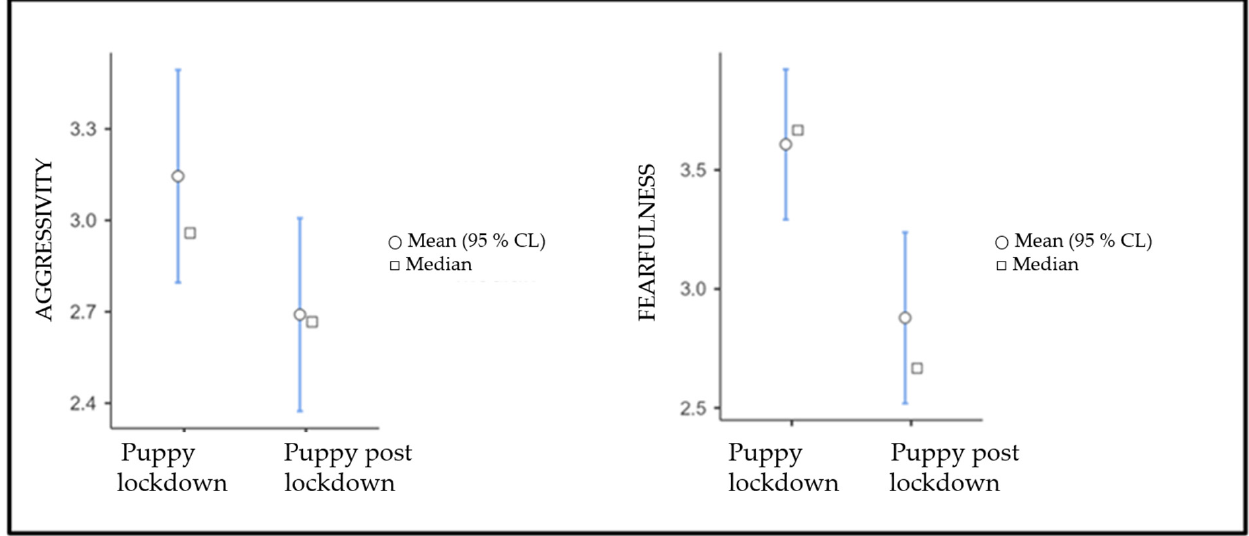
Figure 1. Differences in the aggressiveness and fearfulness traits in the “puppy lockdown” sample group.